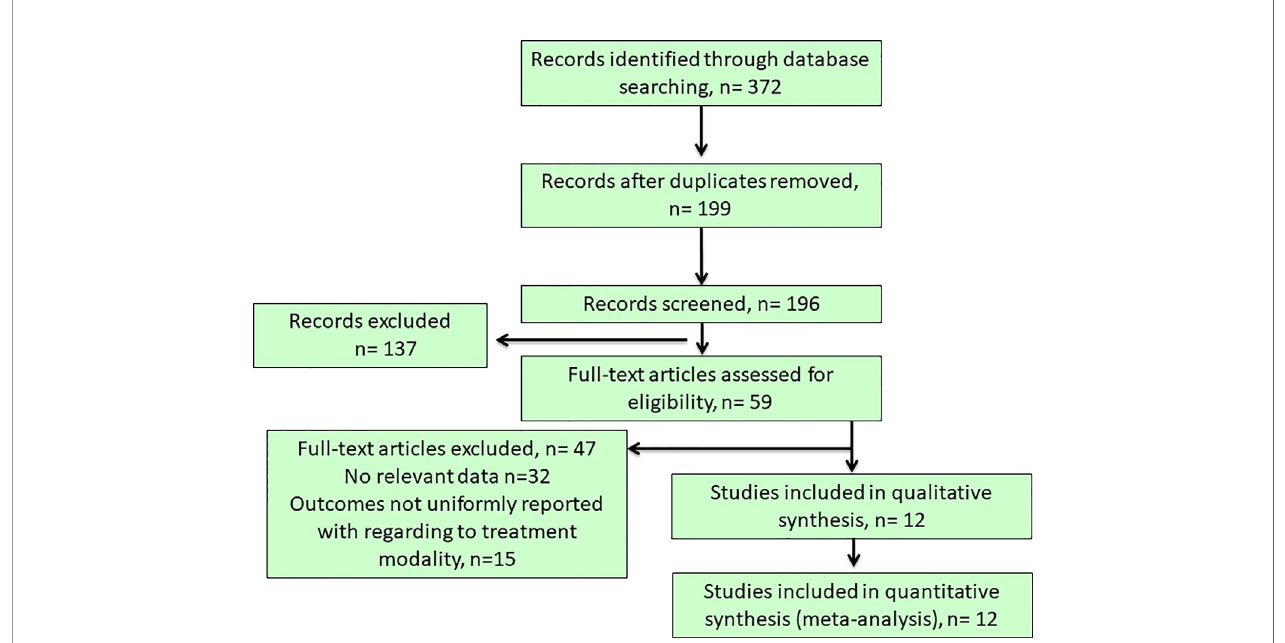
FIGURE 1 | Flow chart of literature search and study selection. Our initial literature search yielded a total of 372 articles from the selected databases and after the removal of duplicated and irrelevant records, 59 articles with full-text articles were further reviewed. Among them, 32 did not show relevant data, while other 15 articles reported outcomes non-uniformly with regard to the target treatments. Finally, 12 studies was included in this study.